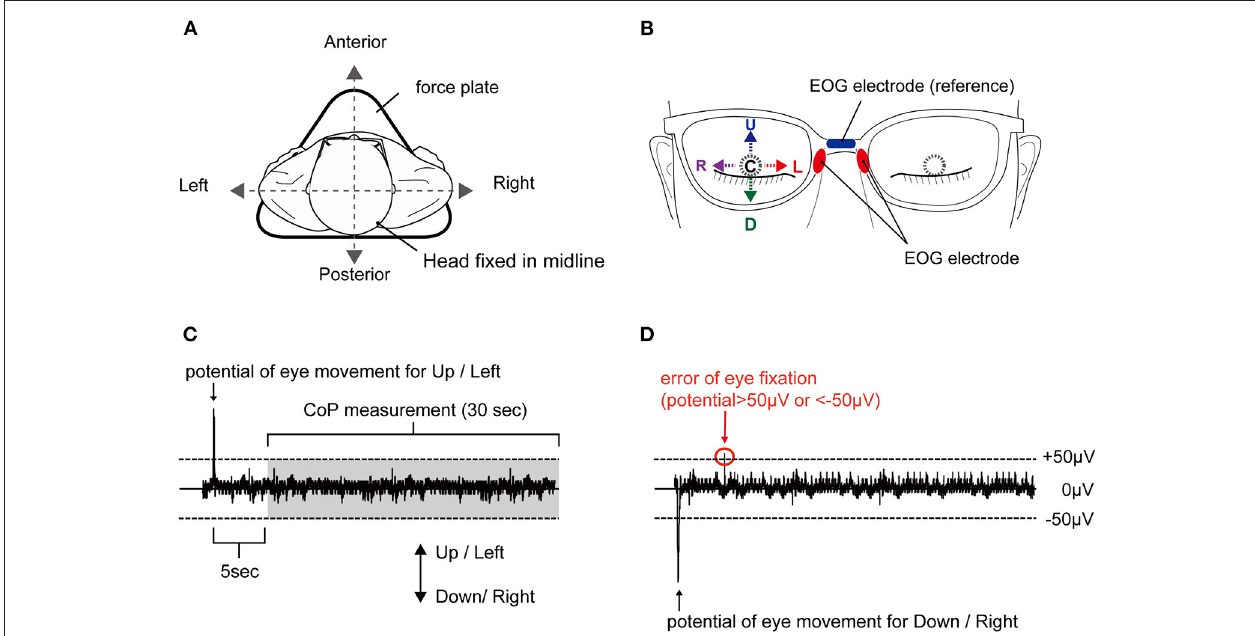
FIGURE 1 | Experimental setup and typical EOG waveform. (A) Body sway was measured in a static standing position on a force plate, with no head movement. (B) Eye positions corresponding to E-Up (U), E-Down (D), E-Right (R), E-Left (L), and E-Center (C). (C) Appropriate waveform and (D) inappropriate waveform. A plus sign reflects a shift to the anterior, and a minus sign reflects a shift to the posterior. The waveform is considered inappropriate with an EOG of ± 50 µ V or higher in a direction different from the target direction. EOG, electrooculography.